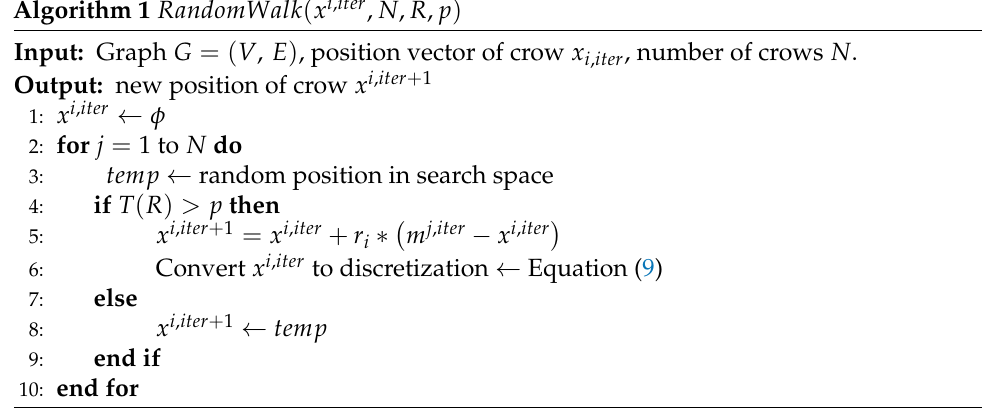
Algorithm 1 RandomWalk ( x i , iter , N , R , p